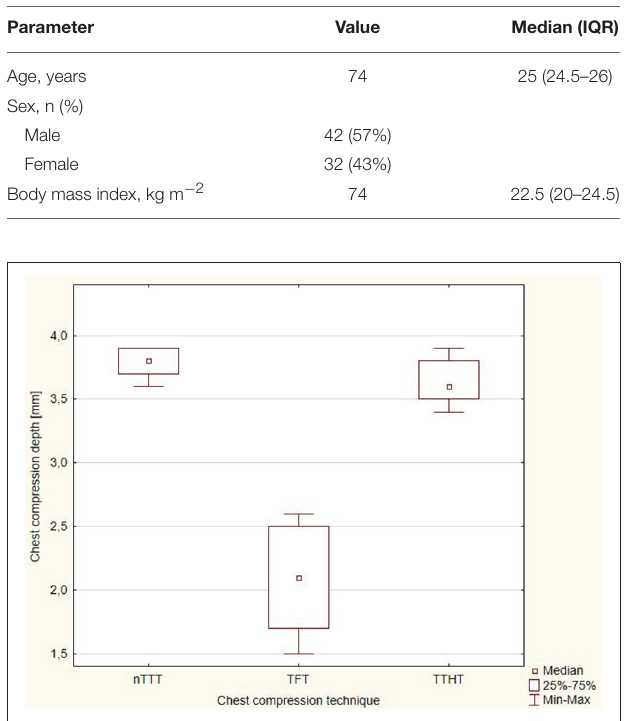
FIGURE 3 | The distribution of chest compression depth with time.